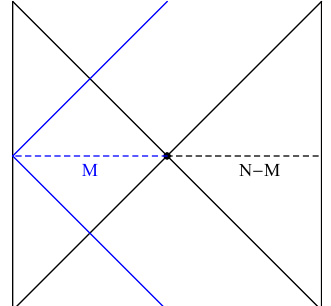
Figure 8. A boundary CFT in the AdS 2 background. The right boundary is the conventional AdS boundary. Boundary conditions associated with the projective measurement of part of the left Majorana fermions are imposed at the left boundary. An ETW brane visible to M bulk fermions is depicted in blue, where M is the number of fermions measured in the left